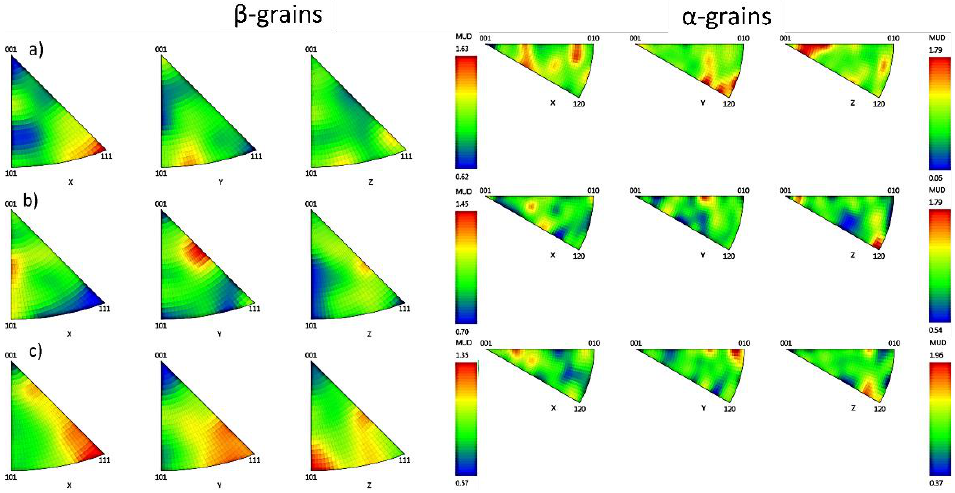
Figure 11. IPFs of the β and α grains obtained after milling at ( a ) 40 h, ( b ) 60 h and ( c ) 40 h in the continuous mode of the sintered samples.